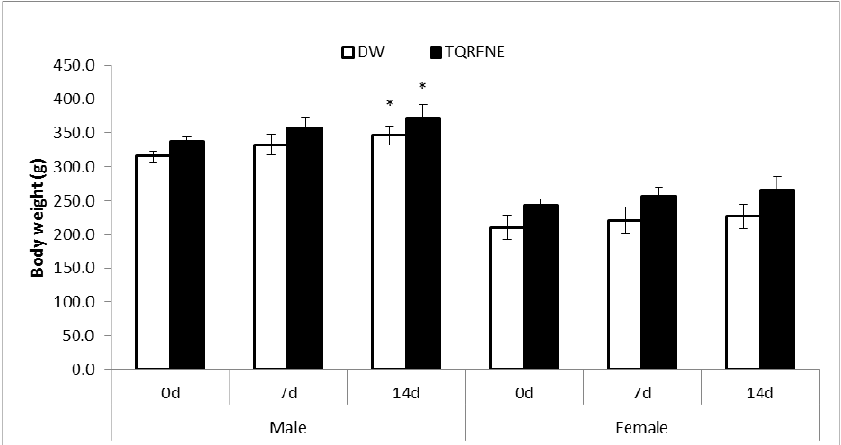
Figure 1. Effects of oral administration of thymoquinone-rich fraction nanoemulsion (TQRFNE) and distilled water (DW) on body weights of male and female rats (n = 5). For each gender P values < 0.05 were considered as significant using one way ANOVA followed by Least Significant Difference (LSD). Asterisks on bars of 7 th and 14 th days denote significant difference compared to day 0 in each